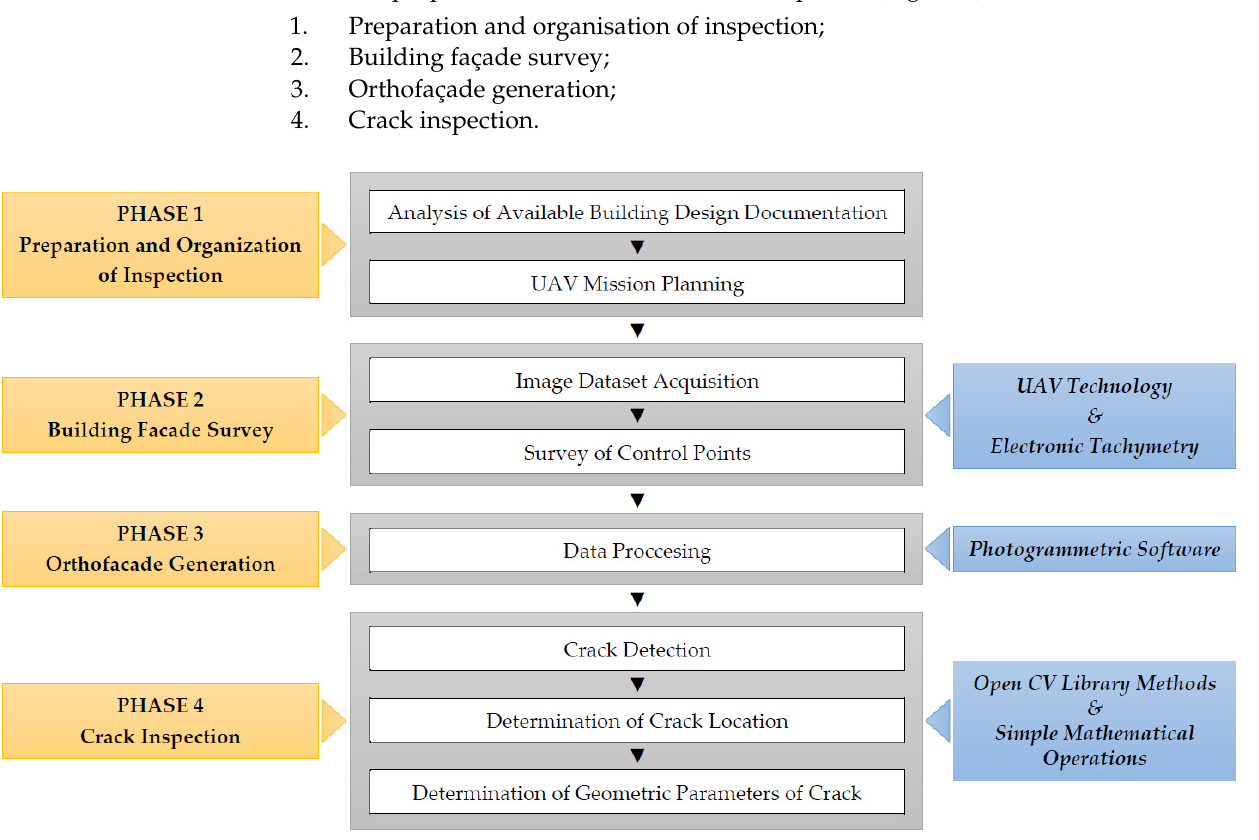
Figure 1. AIM workflow: phases, activities and techniques.